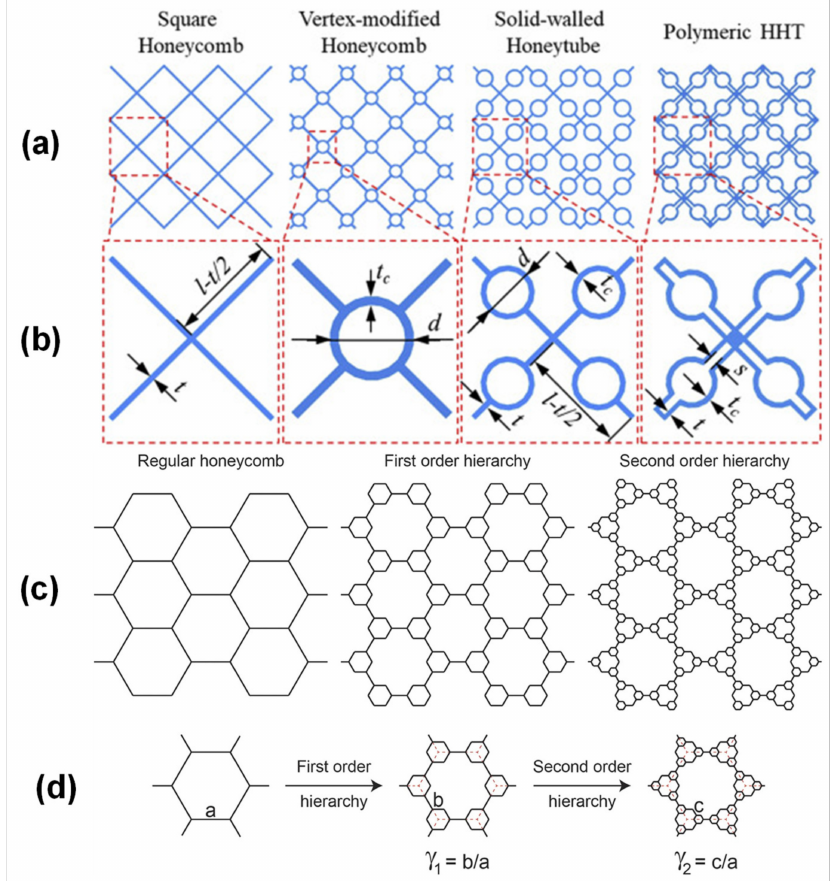
Figure 9. ( a , b ) Illustration of HHTs together with square honeycomb, vertex modified honeycomb, solid walled honeytubes, and polymeric HHT [66]; ( c ) Regular, first order, and second order hierarchy; ( d ) Process of converting unit cell from first order to second order hierarchy